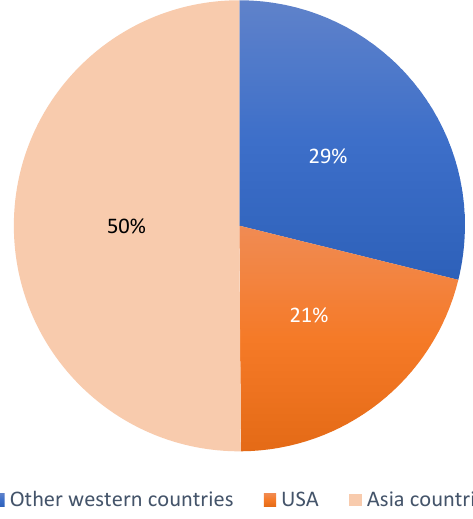
Figure 7. Regions where the studies were conducted.